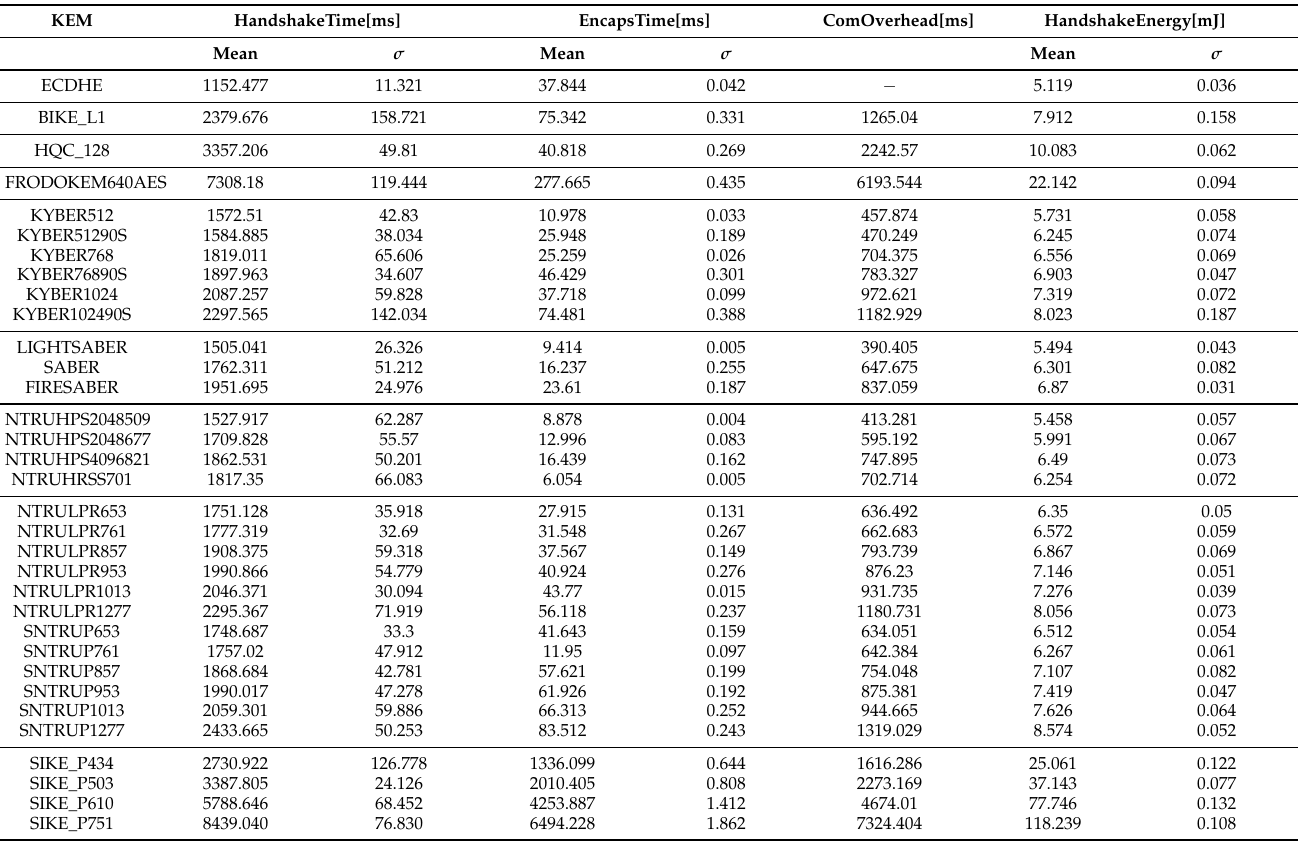
Table A1. The measured latency and energy consumption of the TLS 1.2 handshakes with post- quantum KEMs. σ denotes the standard deviation of the measurements.